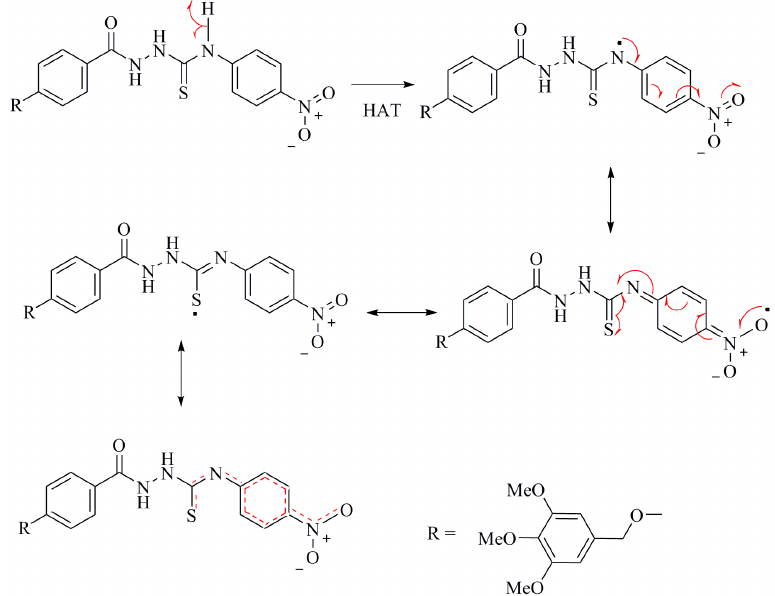
Scheme 4. Delocalization of the electron in the radical of compound 3f .